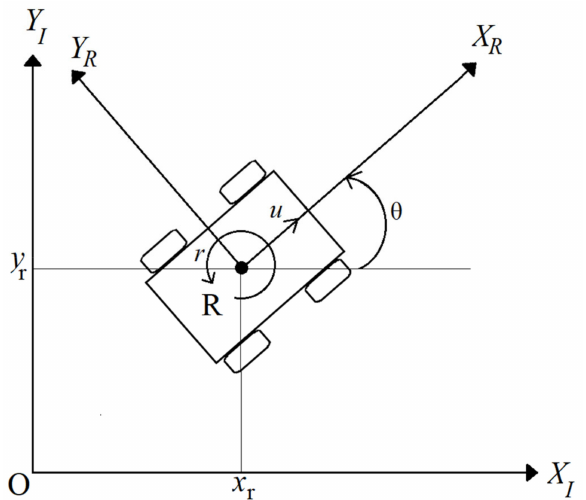
Figure 1. Mobile robot kinematics within a 2D planar surface (see text for symbol and parameter